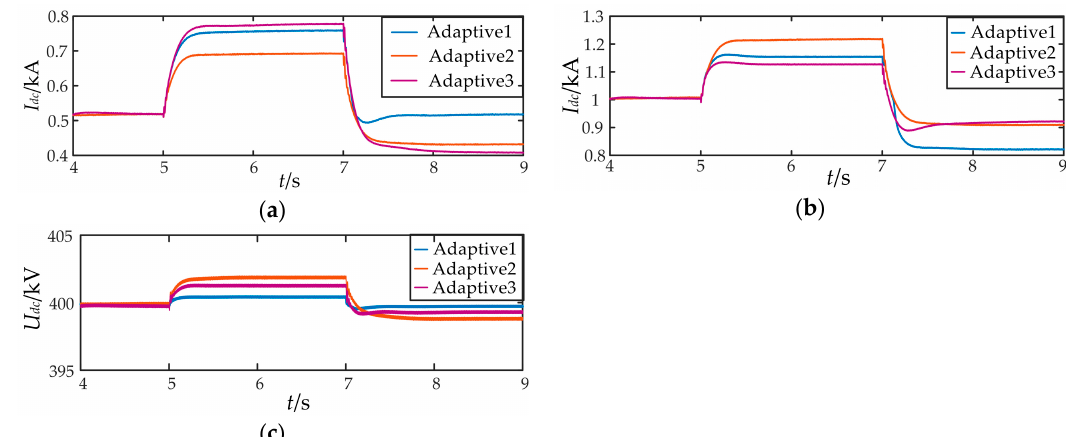
Figure 18. Simulation waveforms of active power fluctuation: ( a ) DC current of LCC3; ( b ) DC current of LCC4; ( c ) DC voltage. Where Adaptive1, Adaptive2, and Adaptive3 denote the adaptive droop control strategy proposed in this paper, the adaptive droop control based on DC voltage deviation, and the adaptive droop control based on the DC voltage deviation coefficient and power distribution coefficient, respectively.